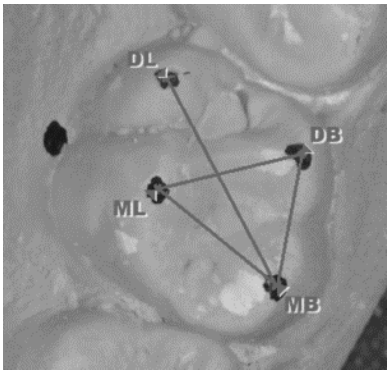
Figure 3. Intercuspal distances measured on an upper first molar.